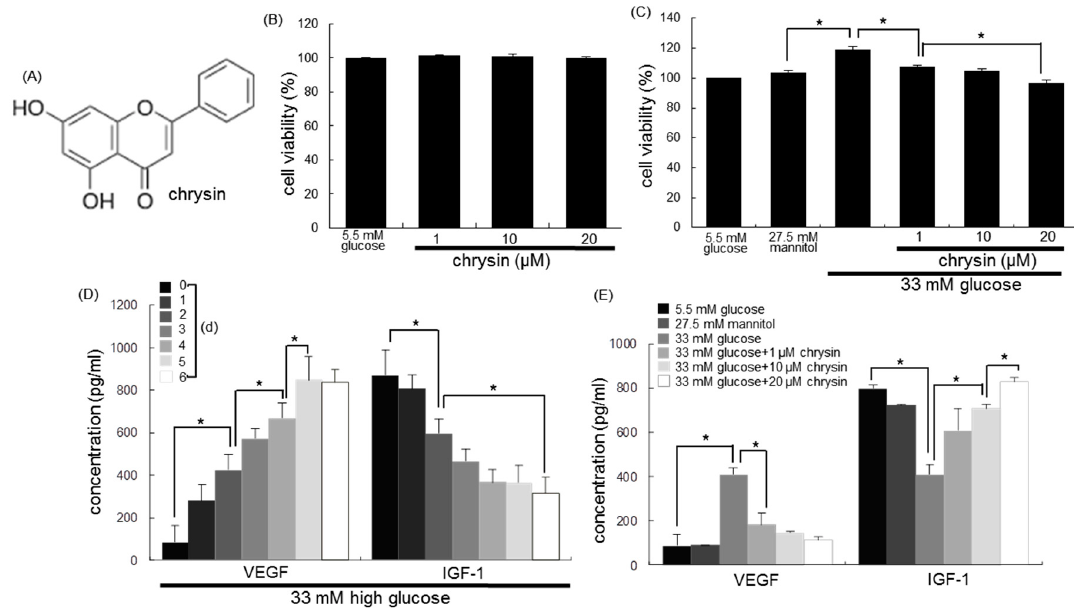
Figure 1. Chemical structure ( A ) and retinal pigment epithelial cytotoxicity ( B ) of chrysin, and the inhibitory effects of chrysin on cell proliferation by glucose ( C ), and temporal responses ( D ) and the inhibition of antivascular endothelial growth factor (VEGF) and insulin-like growth factor-1 (IGF-1) secretion by chrysin ( E ) in human retinal pigment epithelial (RPE) cells. Cells were incubated with 33 mM of glucose in the absence and presence of between 1–20 μ M chrysin for up to six days. Cells were also incubated with 5.5 mM of glucose and 27.5 mM of mannitol as osmotic controls. After RPE cells were cultured in high glucose media, cell viability was measured by using MTT (3-(4,5-dimethylthiazol-2-yl)-2,5-diphenyltertrazolium bromide) assay ( B and C , 100% viability with 5.5 mM of glucose). The secretion of VEGF and IGF-1 was measured with commercial ELISA kits ( D and E ). * Values in bar graphs (mean ± standard error of the mean (SEM), n = nine independent experiments) indicate significant different at p <